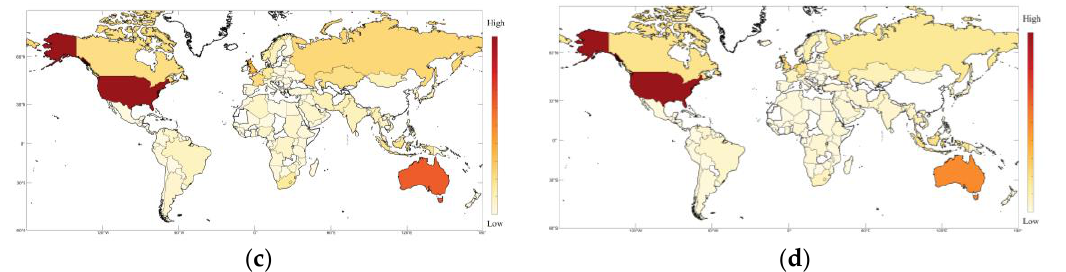
Figure 2. Foreign Direct Investment Stock’s Perennial Change Zoning Map. ( a ) – ( d ) represent Foreign Direct Investment Stock risk in 2004, 2009, 2014, 2019.